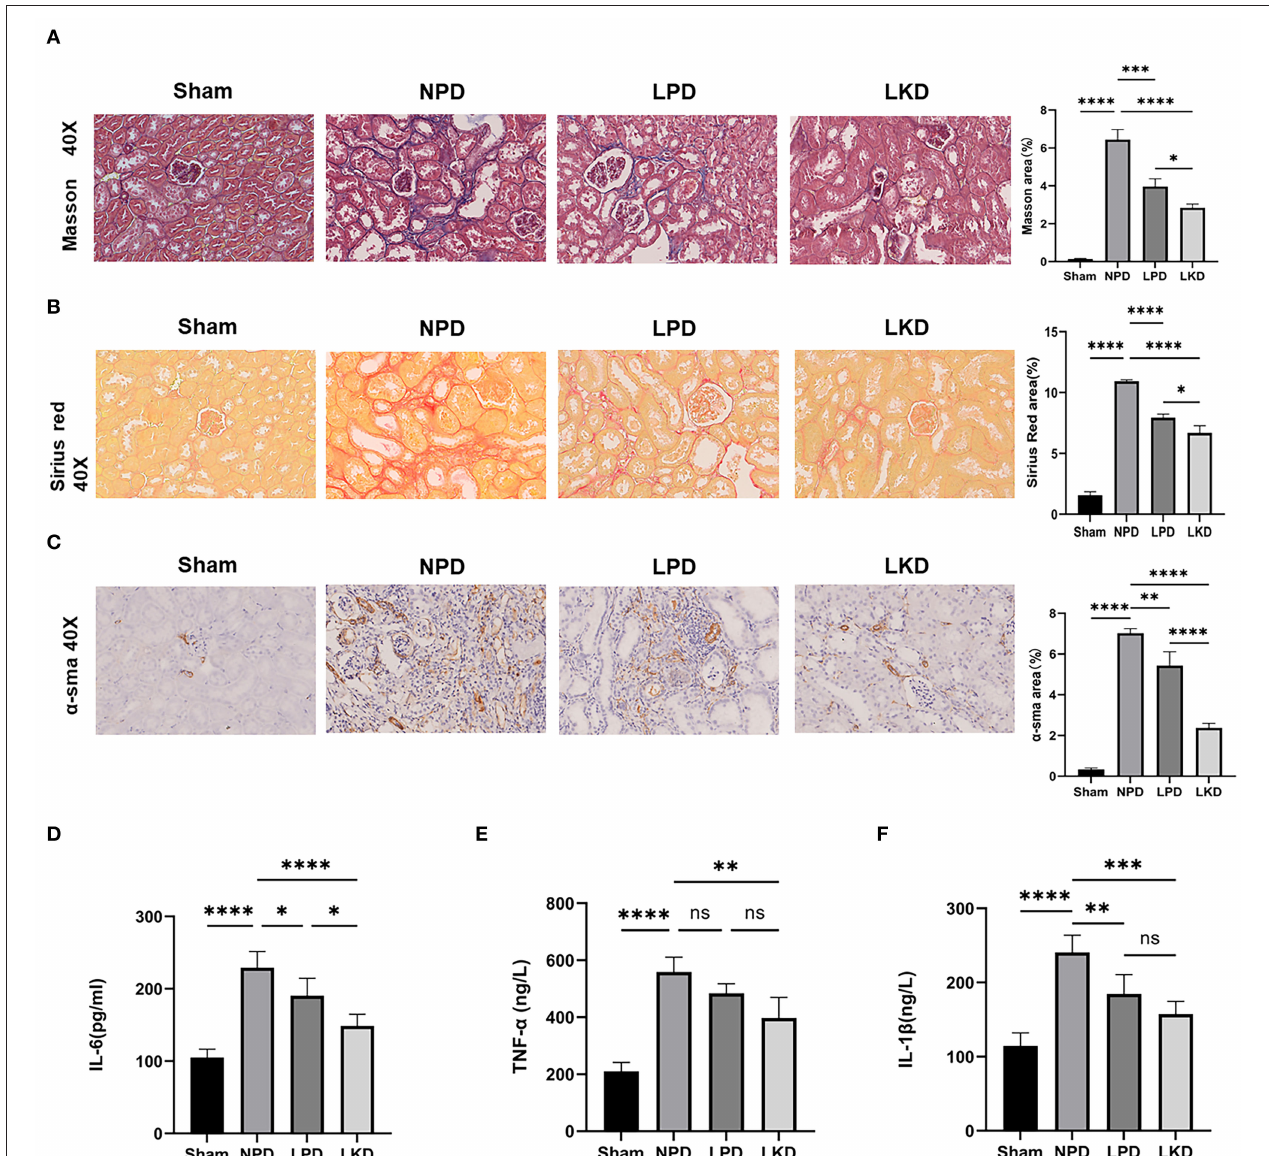
FIGURE 2 | LKD attenuate renal fibrosis and decrease inflammatory factors. (A) Representative images (40 × ) for Masson staining of kidney tissues and fibrosis area score (ANOVA test). (B) Representative images (40 × ) for Sirius red staining of kidney tissues and fibrosis area score (ANOVA test). (C) Representative images (40 × ) for immunohistochemical α -SMA of kidney tissues and fibrosis area score (ANOVA test). (D–F) Comparison of inflammatory factors by ELISA. (D) IL-6, (E) TNF- α , (F) IL-1 β (ANOVA test). Ns, not significant; * p < 0.05; ** p < 0.01; *** p < 0.001; **** p < 0.0001.